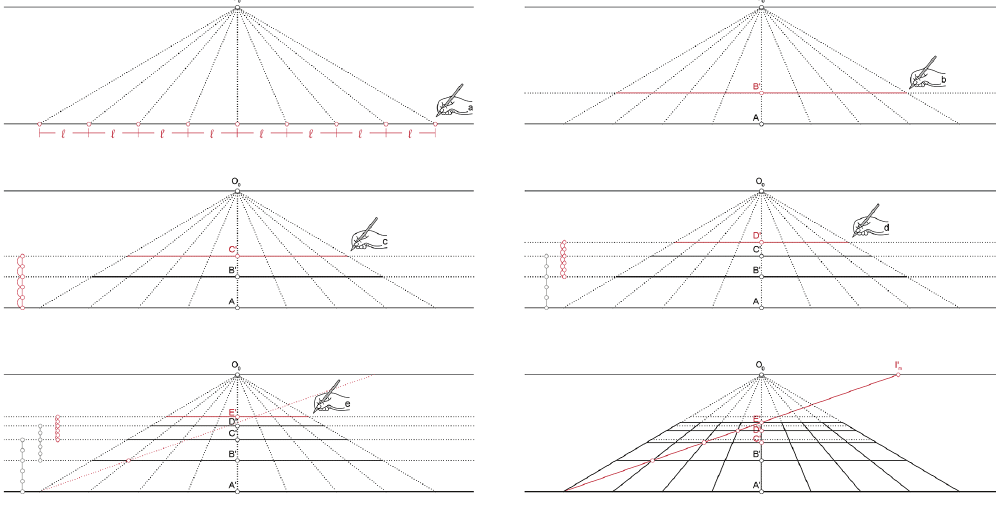
Figure 3 Illustration of